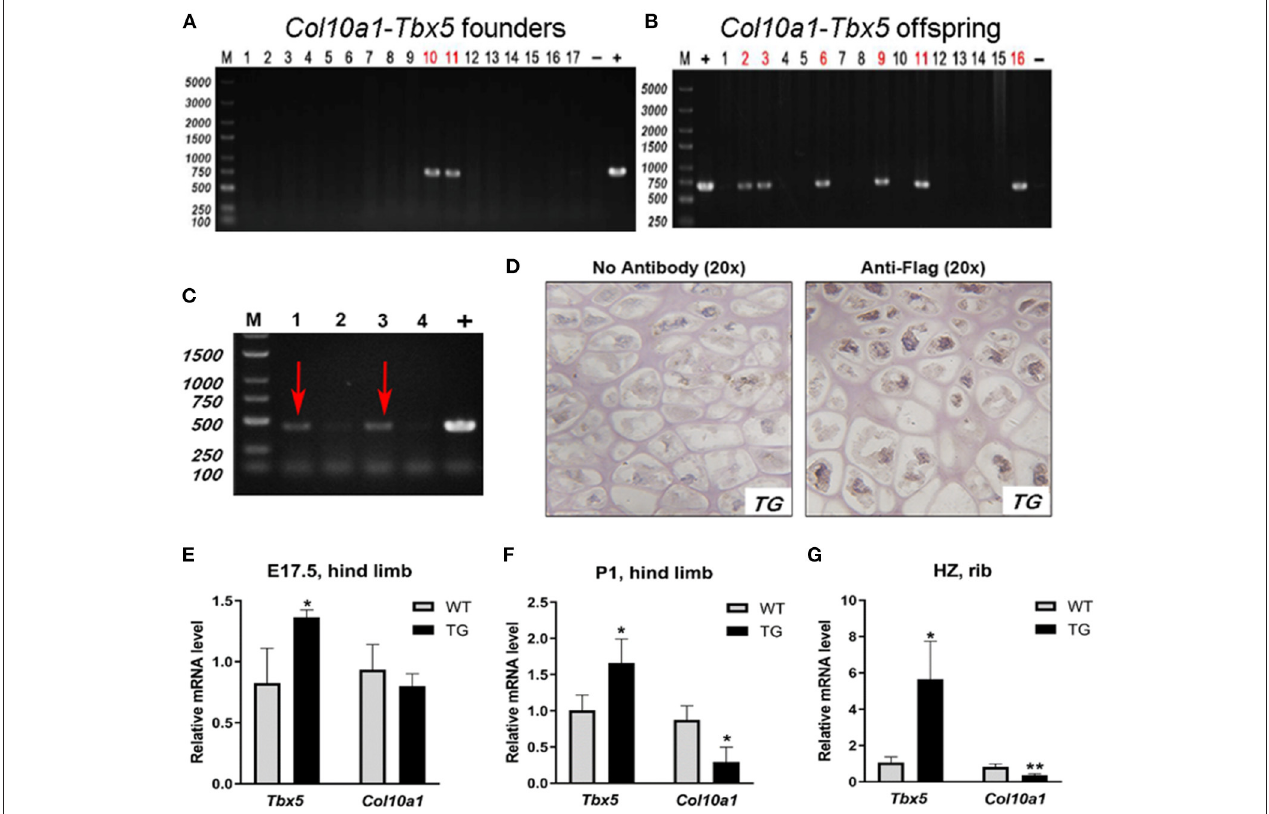
FIGURE 7 | Expression of transgene and Col10a1 mRNA in Col10a1-Tbx5 TG mice. (A) Col10a1-Tbx5 transgenic mouse lines. PCR genotyping using mouse skin genome DNA and Col10a1-Tbx5 fragment specific primers indicated that we have successfully generated transgenic founders with ∼ 10% positive rate (lanes 10, 11). (B) Genotype of the offspring of the transgenic founders breeding with wild-type mice was confirmed by PCR either and showed the establishment of Col10a1–Tbx5 transgenic mouse lines. (C) RT-PCR confirmed transgene expression in Col10a1-Tbx5 TG mice (red arrows). (D) Immunohistochemistry staining was used to analyze Flag expression in TG mouse hind limb sections. Dark brown staining shows Flag expression in hypertrophic chondrocytes of the proximal tibia in a TG mouse (right panel; control with no antibody, left panel). (E–G) Tbx5 expression was upregulated in TG mice compared with WT mice at each age, whereas Col10a1 expression was downregulated in limb tissue on P1 and the hypertrophic zone on P7. * p < 0.05, ** p < 0.01.